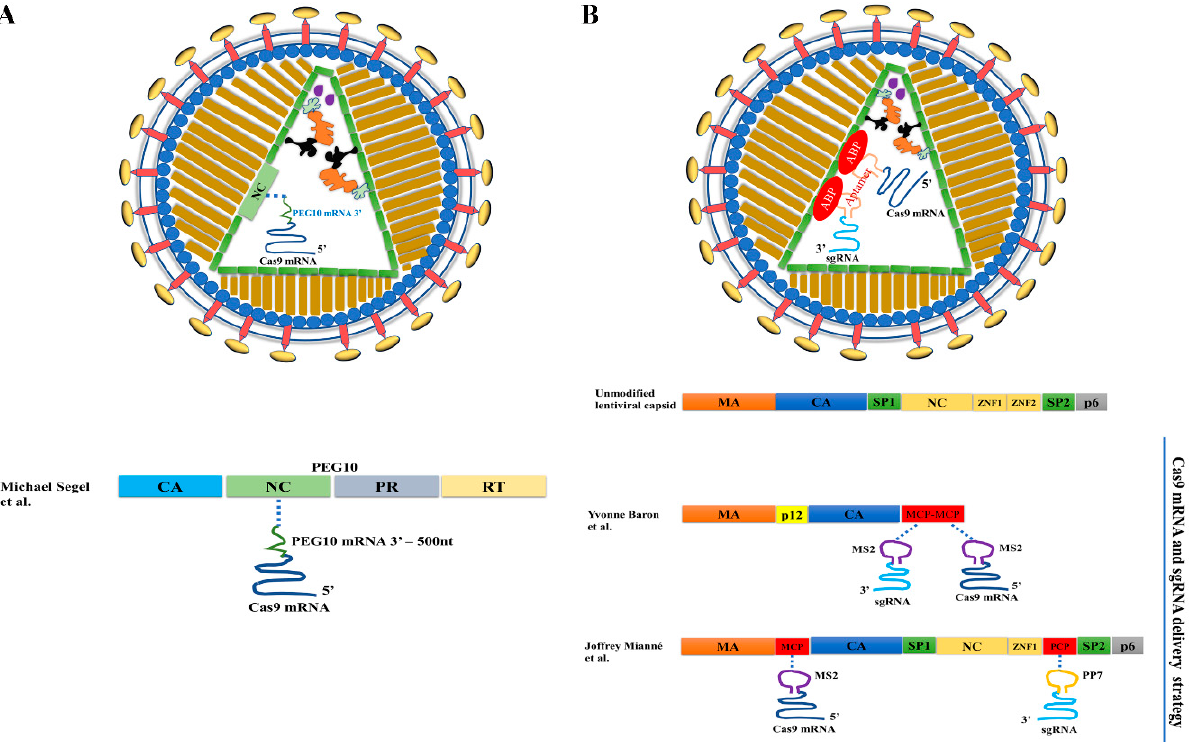
Figure 3. Using VLPs to deliver mRNA for genome editing. ( A ) Viral capsid-derived RNA-delivering VLPs. Aptamers are added in Cas9 mRNA and sgRNA so that they can be packaged via aptamer/ABP interactions. The RNAs do not contain a long terminal repeat, so reverse transcription cannot happen. ( B ) Mammalian transposon protein-derived VLPs for RNA delivery. The VLPs were reported in references [11], [15] and [16]